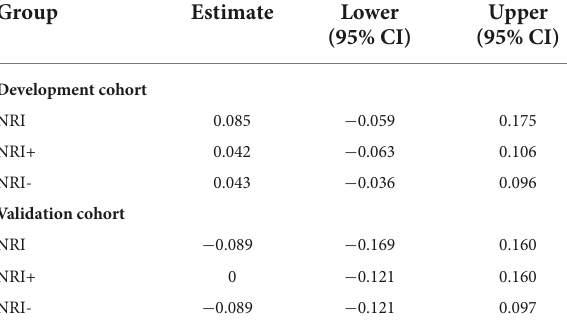
TABLE 3 The calculated net reclassification index (NRI) in the development cohort and validation